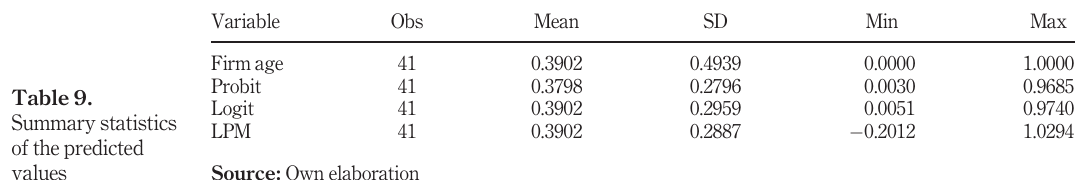
Table 8. Summary statistics of the predicted